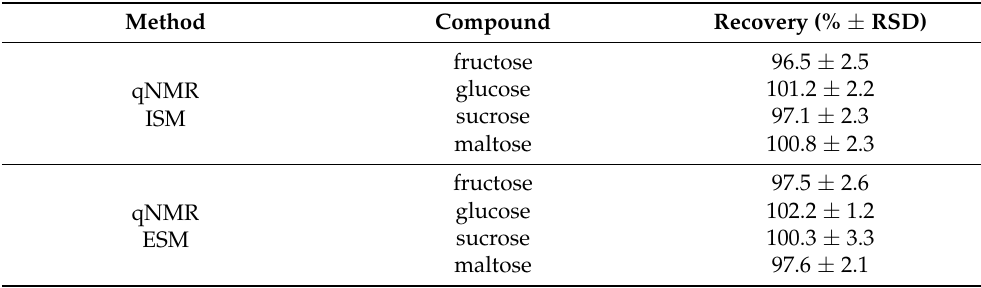
Table 4. qNMR assay accuracy for compounds. Inter-day recovery values (n = 6) expressed in percentage amount added (mean ± RSD).